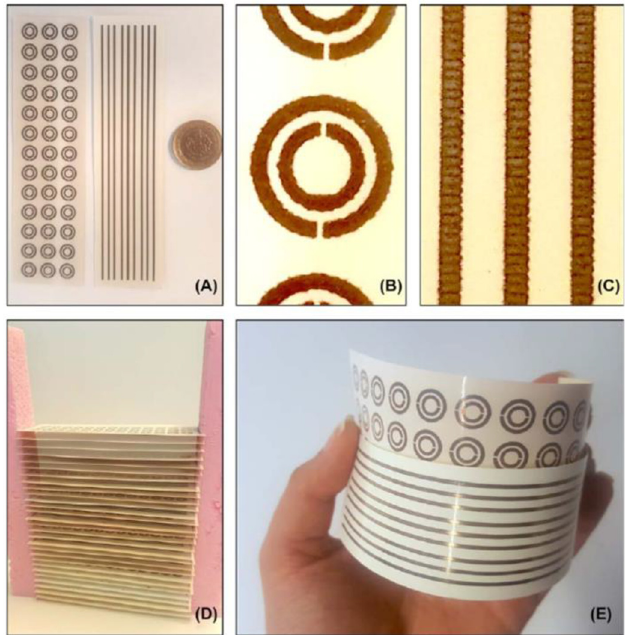
Fig. 2. Various pictures of the fabricated samples, that is, SRRs and thin wires, as well as their combination to construct a H. İ bili et al., Microw. Opt. Technol Lett. 60 , 187